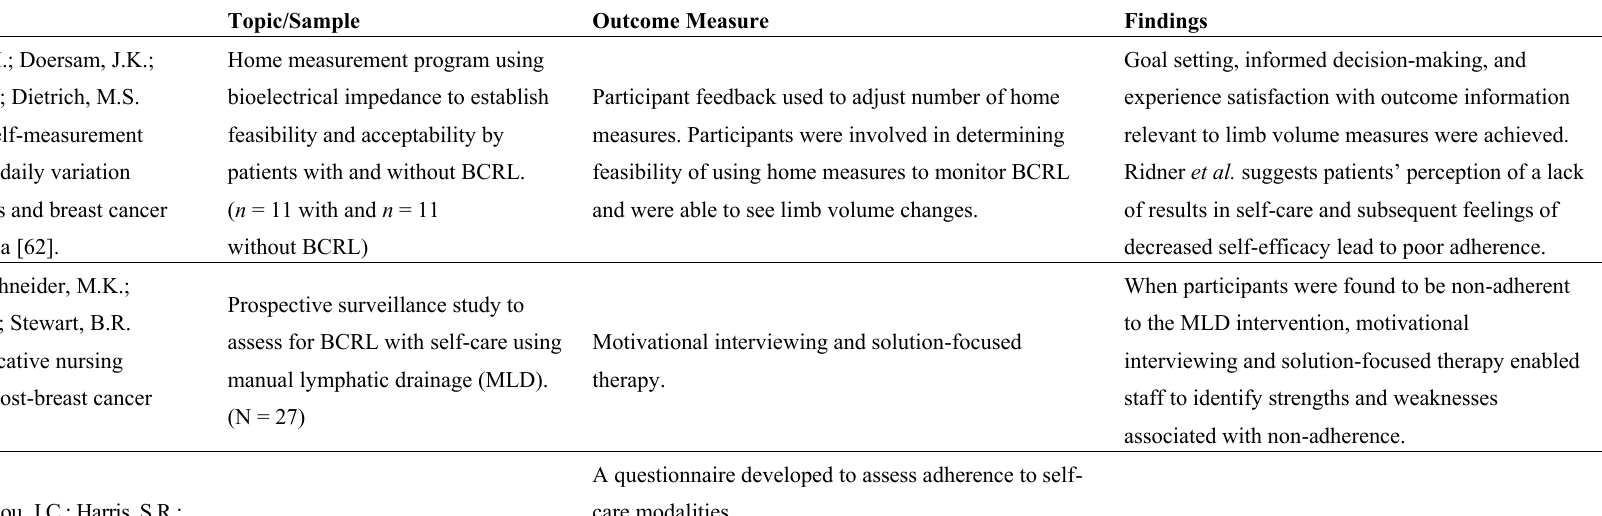
Table 2. Summary of adherence